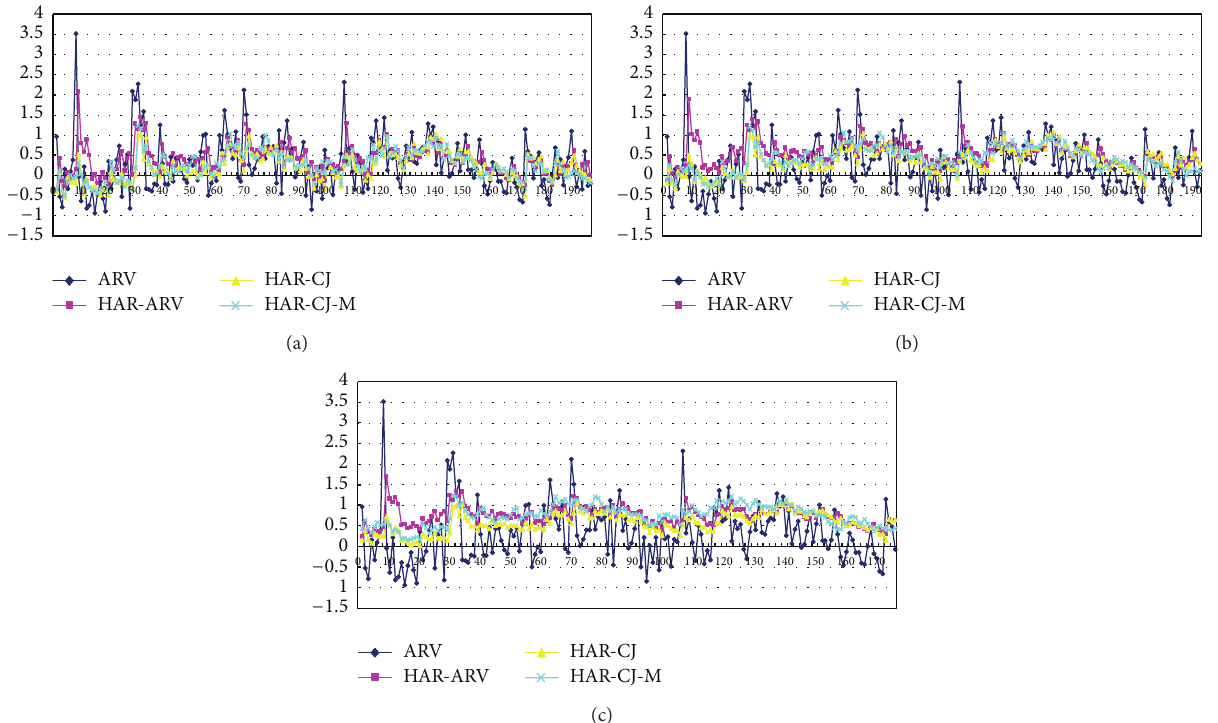
Figure 3: (a) Comparison of the out-of-sample forecasting performance of the HAR-ARV, HAR-CJ, and HAR-CJ-M model (1 day). ARV represents the true volatility; HAR-ARV, HAR-CJ and HAR-CJ-M represent the forecast volatility of the HAR-ARV, HAR-CJ, and HAR-CJ- M models, respectively. (b) Comparison of the out-of-sample forecasting performance of the HAR-ARV, HAR-CJ, and HAR-CJ-M model (1 week). ARV represents the true volatility; HAR-ARV, HAR-CJ, and HAR-CJ-M represent the forecast volatility of the HAR-ARV, HAR-CJ, and HAR-CJ-M models, respectively. (c) Comparison of the out-of-sample forecasting performance of the HAR-ARV, HAR-CJ, and HAR-CJ-M model (1 month). ARV represents the true volatility; HAR-ARV, HAR-CJ, and HAR-CJ-M represent the forecast volatility of the HAR-ARV, HAR-CJ, and HAR-CJ-M models,